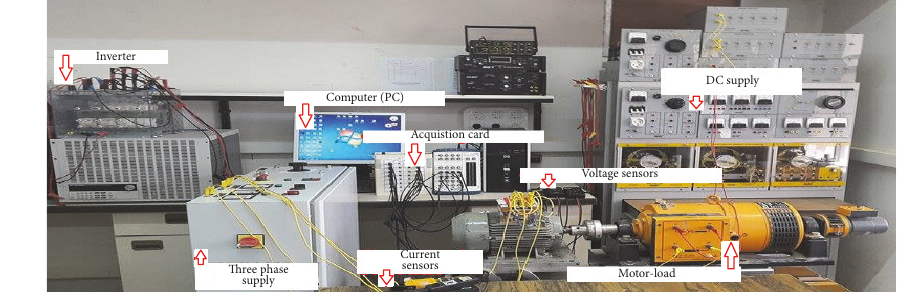
Figure 8: Photo of the experimental test-rig.